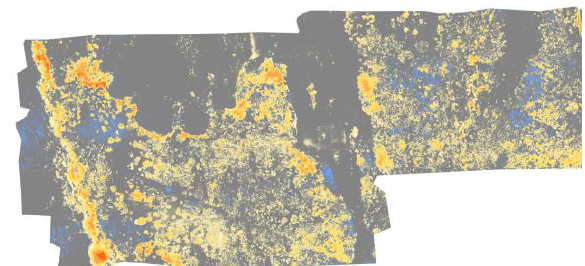
Figure 5. DTM of 2017 subtracted from 2018 of a targeted area. Yellows, oranges and reds indicate negative values (lower points in 2018), grey represents zero difference and blue represents positive